Question: Express in one sentence what the figure is showing.
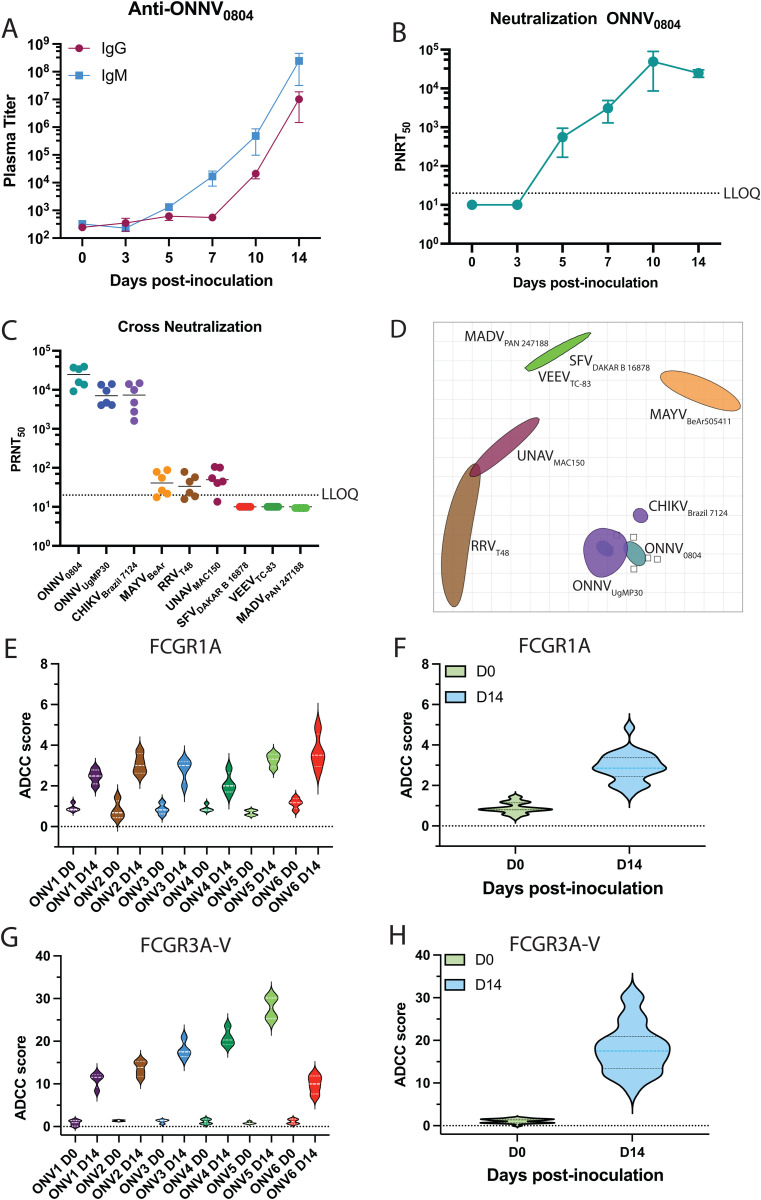
Answer: Characterization of ONNV-specific antibodies and analysis of cross-reactive breadth. A, Development of ONNV-binding, IgM and IgG isotype antibody titers were quantified in macaque plasma at 0, 5, 7, and 10 dpi by ONNV antigen specific ELISA. The LLOQ was a 1:50 plasma dilution. B, ONNV-neutralizing antibodies was quantified in plaque reduction neutralization assays using heat-inactivated macaque plasma at 0–5, 7, 10, and 14 dpi. 50% plaque reduction neutralization titers (PRNT 50 ) were determined in non-linear regression on GraphPad prism. The LLOQ was a 1:20 plasma dilution and undetectable values were graphed as half of the LLOQ. Error bars are SEM. C, Breadth of antibodies of heat-inactivated macaque plasma that neutralized other relevant alphaviruses following ONNV infection (14 dpi) were characterized in cross-neutralization assays against CHIKV, MAYV, RRV, UNAV, SFV, VEEV and MADV using day 0 plasma as a baseline control. The LLOQ was a 1:20 plasma dilution and undetectable values were graphed as half of the LOD. D, Antigenic cartography mapping of the antigenic distances between viruses based upon cross-neutralization data. E,F, Activation of FcγRIA signaling based on NFAT reporter assay separated by individual animals (E) and averaged across all animals (F) for D0 and D14. G,H, Activation of FcγR3A-V signaling for individual animals (G) and averaged across all animals (H) for D0 and D14. Violin plots represent data from two replicate experiments.